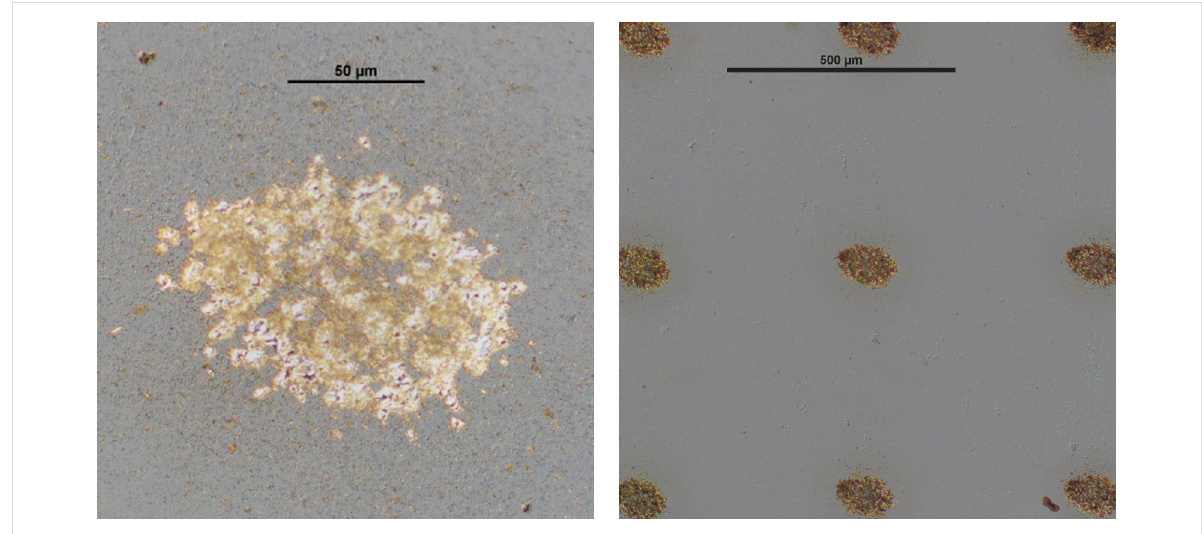
Figure 9: Optical micrographs of LIFT deposits on molybdenum on glass. Cu–In donor layer: 20 nm copper, 200 nm indium. F = 7.8 J/cm 2 . Left: single deposit with higher resolution. Right: array of deposits.